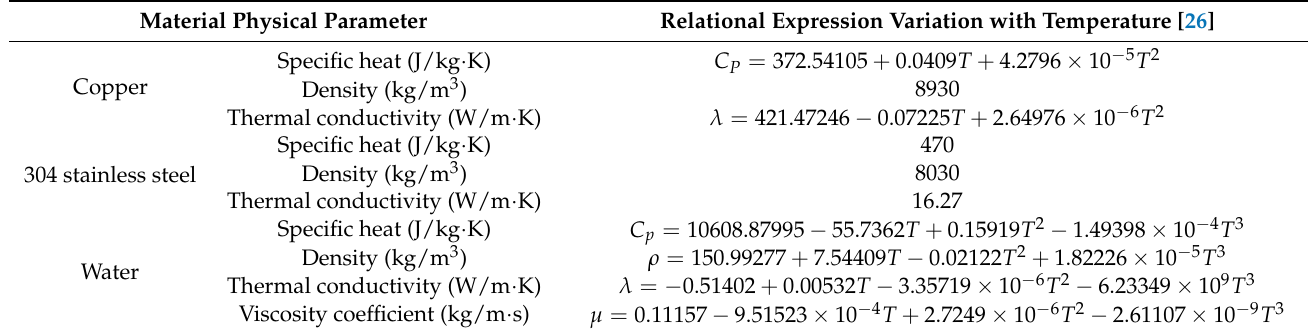
Table 2. Material physical parameters.